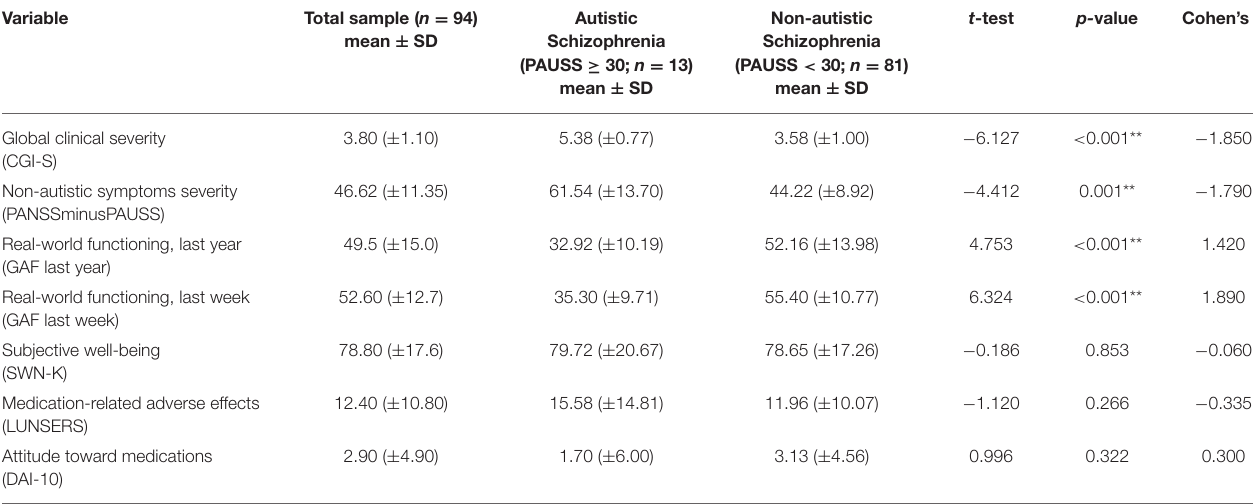
TABLE 2 | Between-group comparison for clinical and functional characteristics. Variable